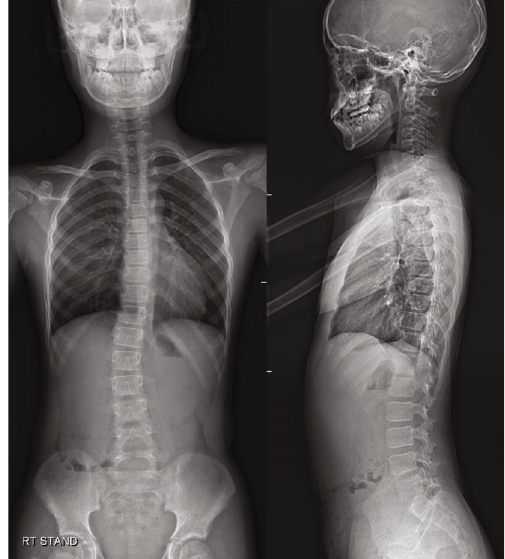
Figure 1: Whole spine plain radiograph. AP and lateral view at the initial visit, at July 9 th , 2012.